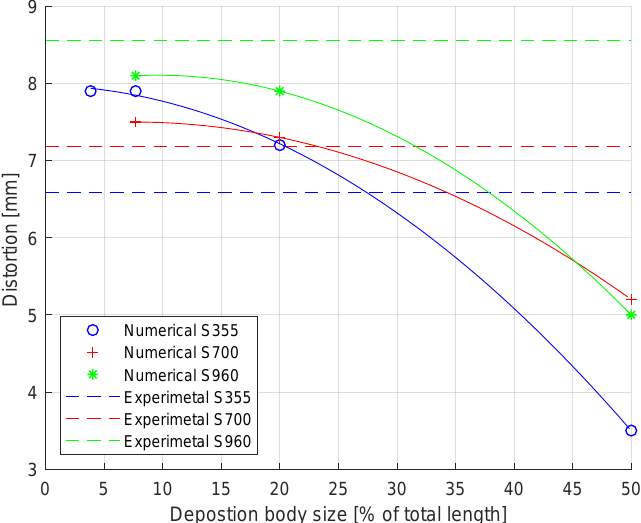
Figure 6. Sensitivity analysis of body deposition size. Experimental results from Bhatti et al. [25].